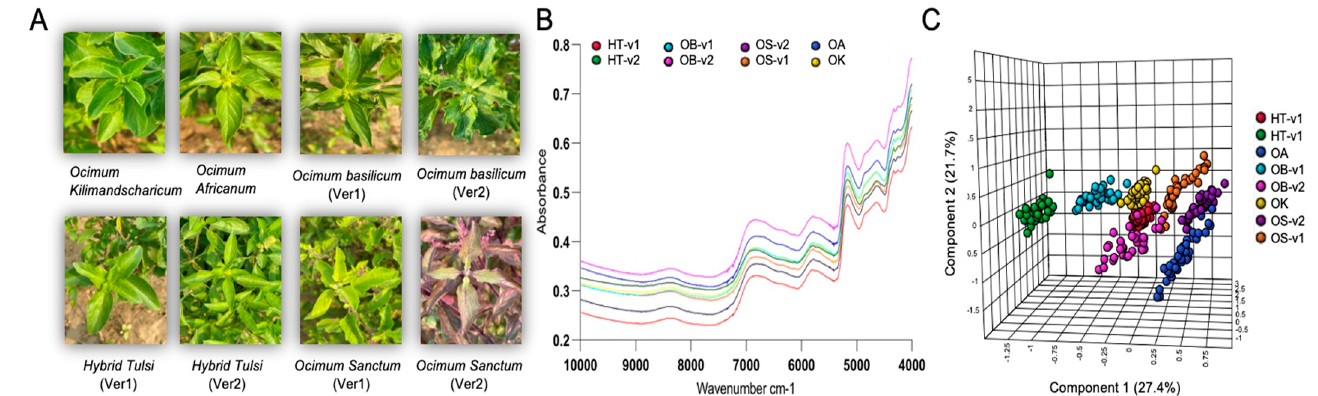
Figure 5. FT-NIR-based rapid metabolic fingerprinting identified species- and variety-specific vari- ation of Ocimum samples. ( A ) Images of eight different Ocimum samples. ( B ) FT-NIR spectrum of average spectra of Ocimum samples from eight different varieties. ( C ) The corresponding PLS-DA plot for the first component (27.4%) vs. second component (21.7%) differentiated the Ocimum species and varieties.